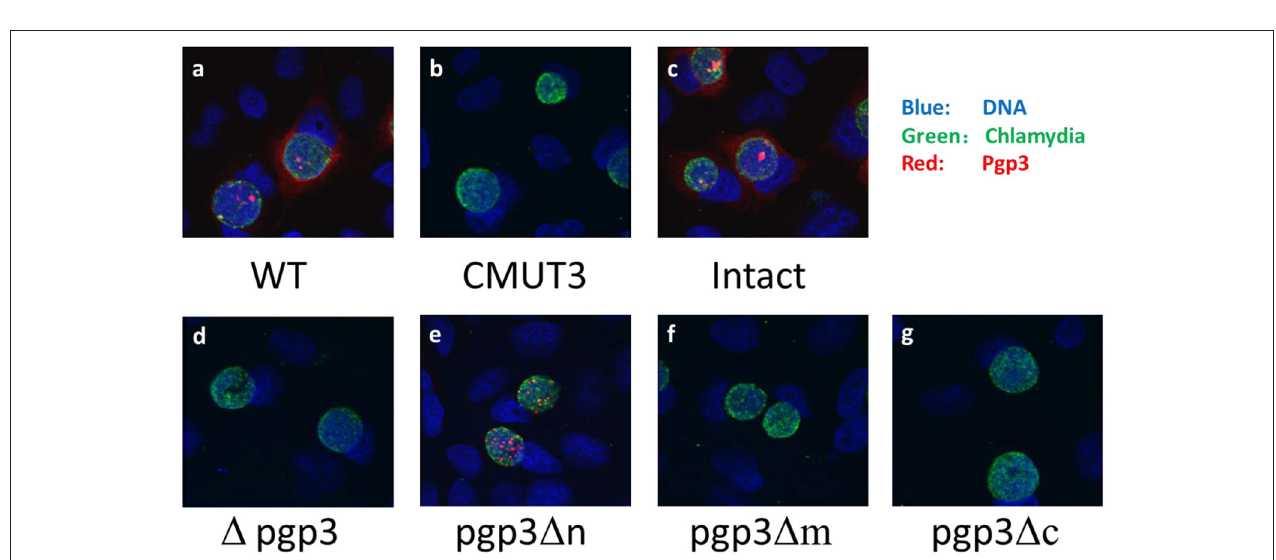
FIGURE 2 | Effect of Pgp3 domain deletion on polyclonal antibody recognition of Pgp3. The wild-type C. muridarum (a) , plasmid-free clone CMUT3 (b) , intact pGFP::CM (c) , and pgp3 full-length deletion mutant ( 1 pgp3, d ), three domain deletion mutants (e–g) were used to infect HeLa cells. The cells were subjected to triple immunofluorescence staining for pgp3 (red), chlamydia (green), and DNA (blue). Only pgp3 1 n was recognized by the anti-Pgp3 polyclonal antibody. pgp3 1 n was localized to the inclusion body, whereas intact Pgp3 was detected throughout the cytosol.